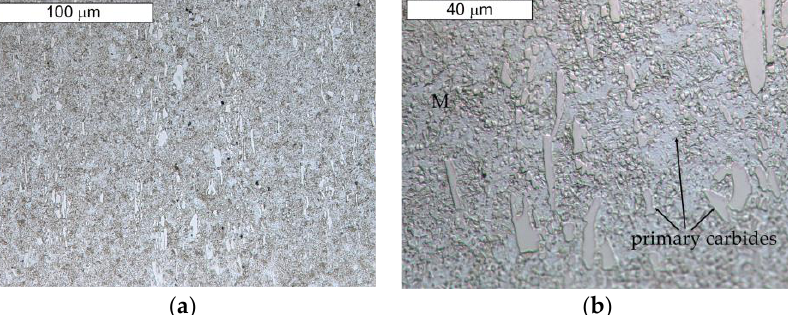
Figure 13. View of ( a ) the microstructure of steel Hardox and ( b ) a magnified fragment of the area in Figure 13a (M — martensite, B — bainite). Light microscopy, etched.